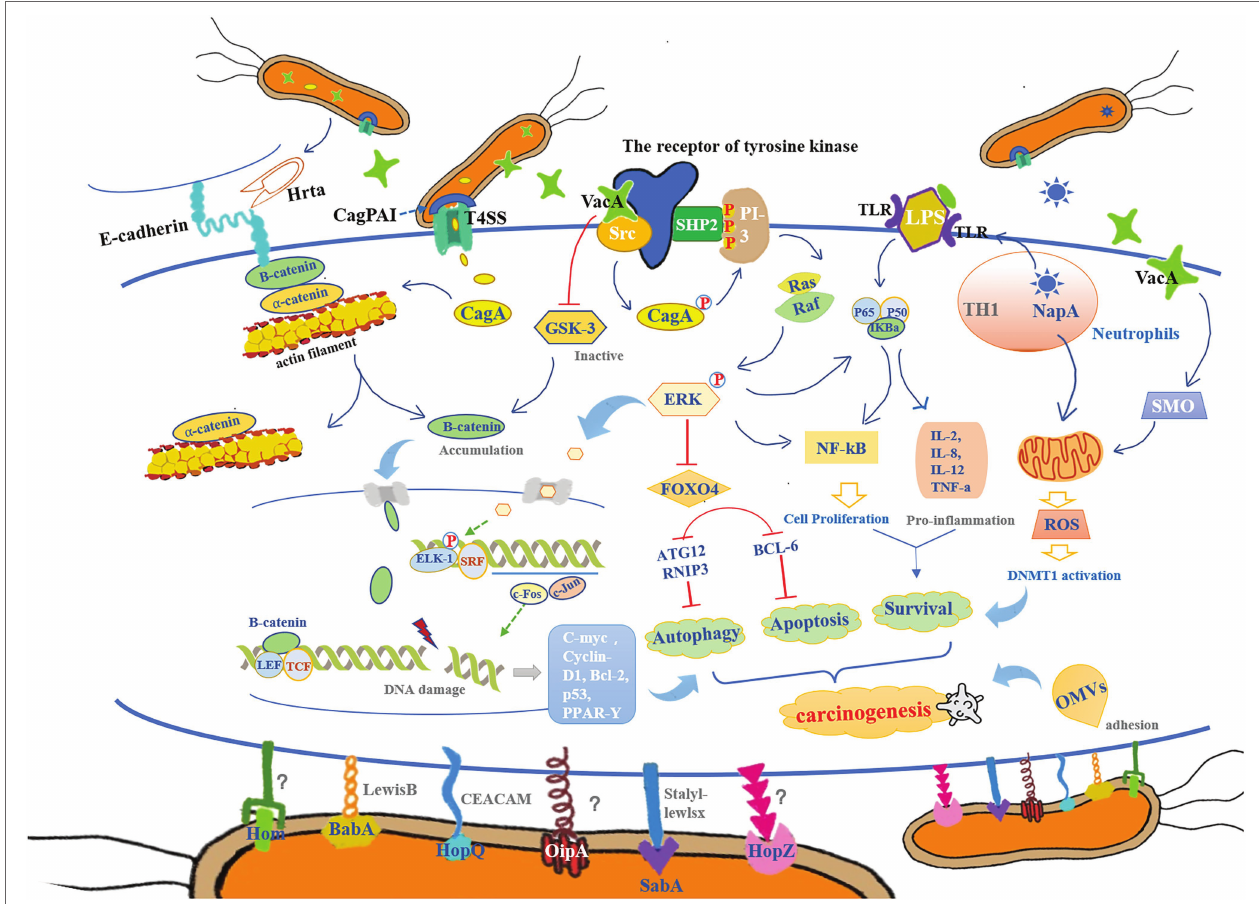
FIGURE 1 | The colonization and reproduction of Helicobacter pylori (HP) are closely related to its chemotaxis, adhesion, colonization, virulence, inflammation, and host immune tolerance. It mediates the inflammatory response in the gastric epithelium through pathological processes such as oxidative stress, DNA methylation, and cell proliferation, which subsequently cause DNA damage, autophagy, apoptosis, and abnormal cell proliferation, to ultimately provide a pathological basis for cancer development. (1) Cytotoxin-associated gene (cag) pathogenicity island (CagPAI) can contribute to the opening of the type-IV secretion system (T4SS) channels and assist in the release of cytotoxin-associated gene A (CagA) from HP into gastric mucosal epithelial cells, thereby promoting the breakdown of β -catenin/a-catenin and actin filament complexes, leading to β -catenin accumulation. In addition, vacuolized cytotoxin (VacA) enters the gastric epithelial cells and further promotes β -catenin accumulation by inactivating GSK-3. When β -catenin enters into the nucleus, it forms a complex with LEF and TCF, thereby activating the expression of genes encoding cyclin D1 (cyclin-D1) and c-Myc, which leads to abnormal cell proliferation. In addition, CagA mediates the NF-kB/ERK/FOXO4 pathway to regulate the apoptotic and autophagic processes in gastric epithelial cells, which is in concert with other pro-inflammatory responses involved in the regulation of physiological processes of cell proliferation that leads to the malignant transformation of gastric mucosal epithelial cells to cancer cells. (2) Hrta secreted by HP, can cut E-calmodulin, disrupt intercellular adhesion, and lose cell polarity, providing conditions for HP colonization. Meanwhile, BabA, SabA, and HopQ can bind to their corresponding receptors on the mucus layer (LewisB, Stalyl–Lewlsx, and CEACAM, respectively), while the receptors of OipA, HopZ, and Hom remain uncleared. These outer membrane proteins (OMPs) promote the HP adhesion to host cells, and in combination with lipopolysaccharides (LPS)-binding complex, lead to the activation of NF-kB and other chemokines [IL-2 and interleukin-8 (IL-8)]. (3) VacA released by HP, can also bind to the receptors of tyrosine kinase, and cause Src to phosphorylate CagA, which triggers SHP2 to bind to PI-3 kinase, allowing the activation of Ras, Raf, and ERK. Phosphorylated ERK translocates to the nucleus with the activation of ELK1 and SRF complexes and induces c-Fos and c-Jun gene expressions. In addition, VacA also increases the activity of spermidine oxidase (SMO); both of these pathways can lead to DNA damage with a high expression of inflammatory factors. (4) NapA, another virulence factor of HP, is recruited by neutrophils that exert a significant role in releasing exogenous reactive oxygen species (ROS) in an attempt to clear the infection of HP, which in turn causes more damage in the gastric